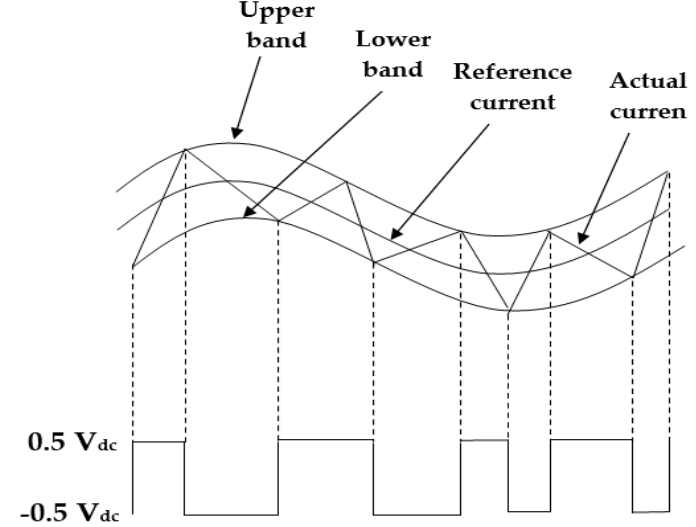
Figure 4. Hysteresis current control technique.